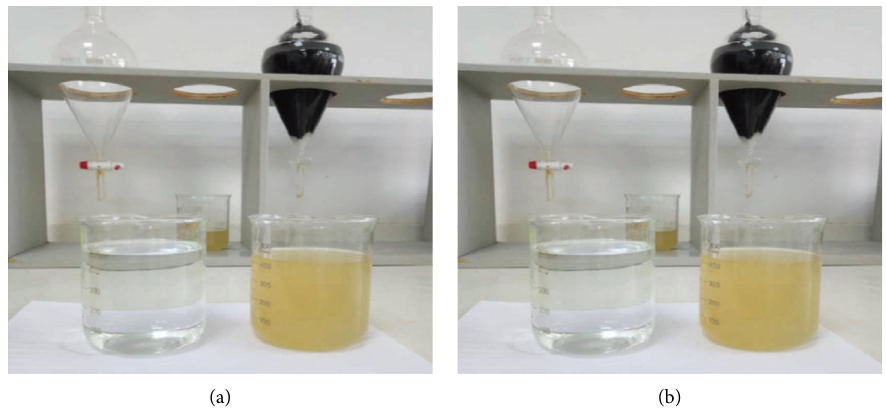
Figure 3: (a) Filtrate from DFSAC lab setup. (b) Mudor WWTP efuent. Table 1: Physicochemical and microbial characteristics of efuent from wk 1 of laboratory-scale fltration setup. Mudor WWTP N